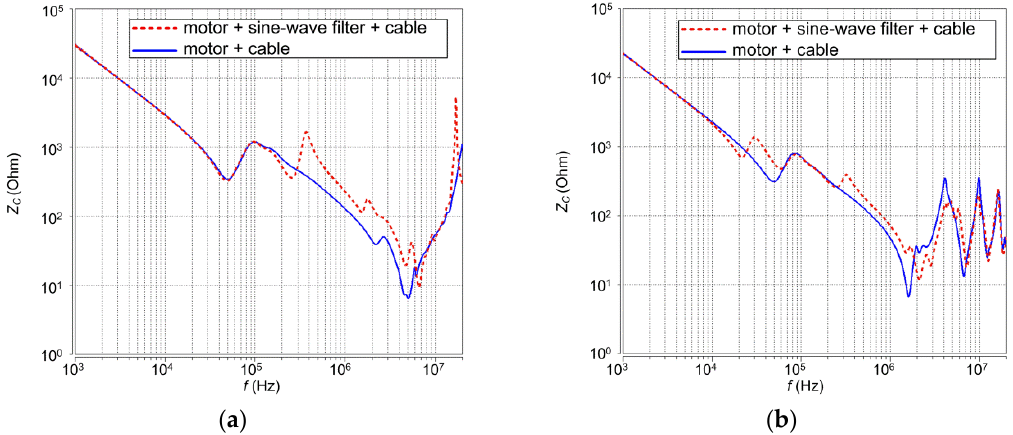
Figure 17. Measured impedance Z C (f) frequency characteristics: ( a ) motor + sine-wave filter ( L S = 3.8 mH, C S = 15 uF) + 1 m